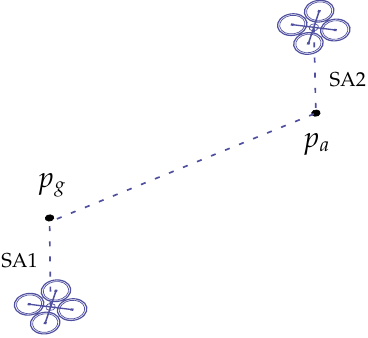
Figure 2. Example of path to be taken for a